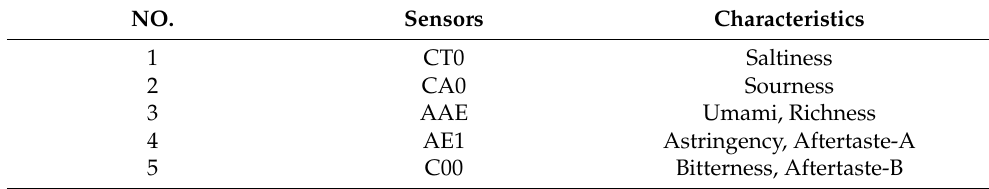
Table 2. Artificial lipid sensors of the